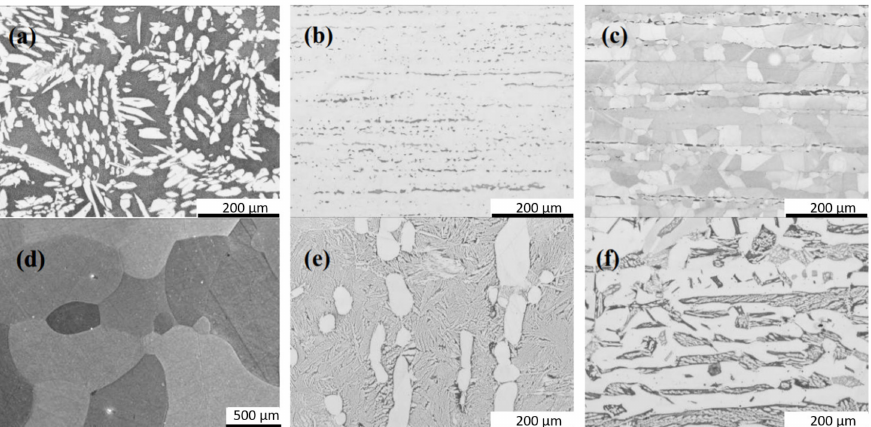
Figure 2. Optical micrographs of the ( a ) CuZn42, ( b ) CuZn38As, ( c ) CuZn36 alloys before heat- treating and ( d ) CuZn42, ( e ) CuZn38As, ( f ) CuZn36 alloys after the heat-treatment process [25].